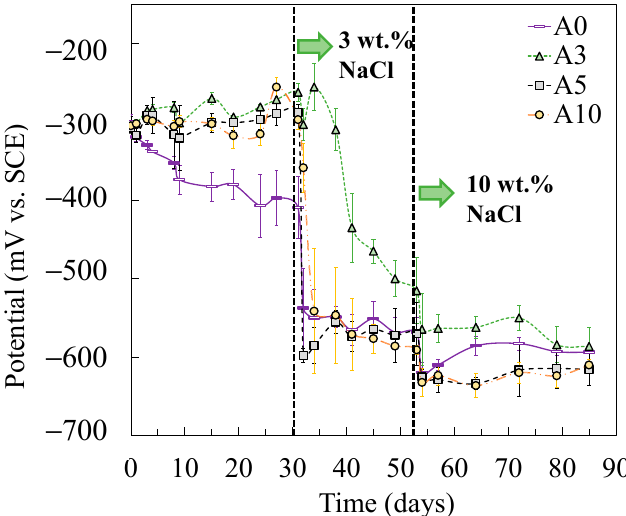
Figure 6. Corrosion potentials of steels subjected to different levels of tensile stress.